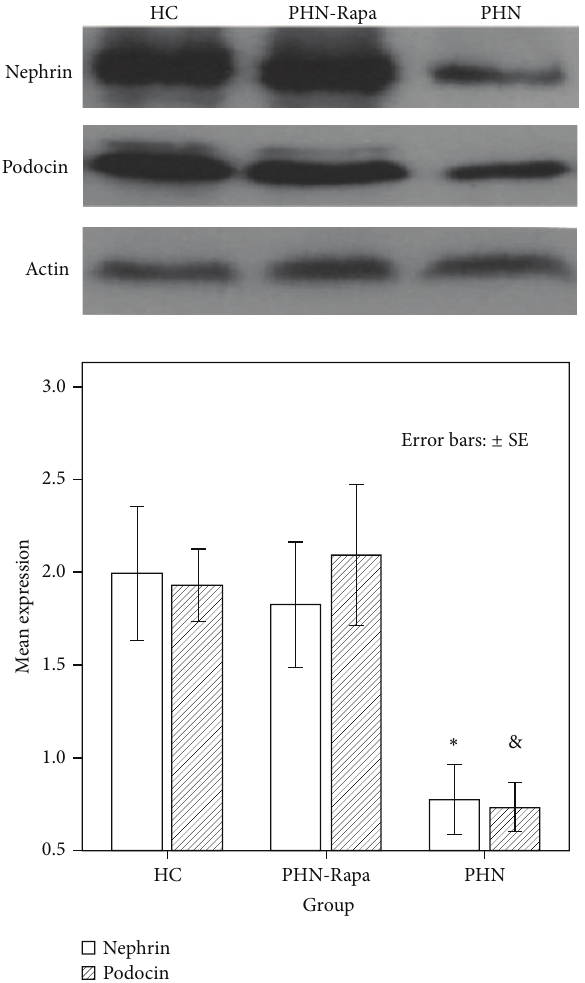
Figure 5: Western blot analysis for nephrin, podocin, and actin in glomerular lysates. HC: healthy controls; PHN: Passive Heymann Nephritis; PHN-Rapa: Passive Heymann Nephritis after rapamycin administration. Bars represent nephrin (white columns) and podoc- in (shaded columns) protein content corrected to actin concentra- tion. ∗ 𝑃 = 0.01 , & 𝑃 = 0.007 . Error bars: ± SE.